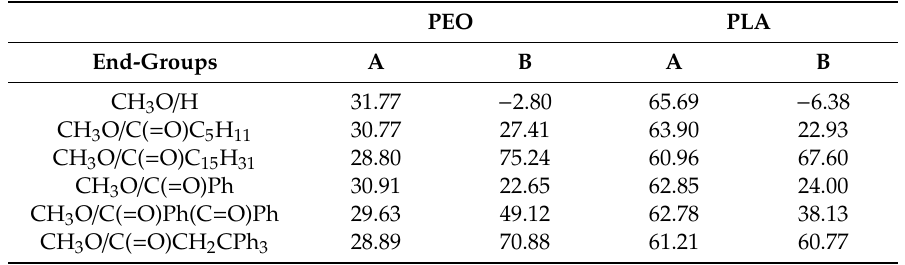
Figure 3. Collision cross section evolution as a function of the degree of polymerization (DP) for singly and doubly charged globular ions for α -methyl ω -hydroxy and α -methyl ω -ester-PEO and PLA samples. Fittings are performed using the equation CCS = A DP 2 3 + B ; the equations and regression coe ffi cients for the smallest (CH 3 OH) and bulkiest (C16) functionalized polymers are shown. Table 2. Collision cross section evolution as a function of the degree of polymerization—parameters obtained from fitted curves for a CCS = A DP 2 3 + B equation (see also Figure